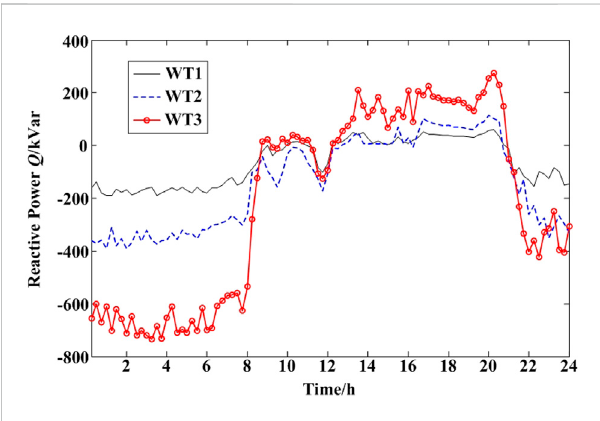
FIGURE 6 Reactive power output curves of dispersed wind